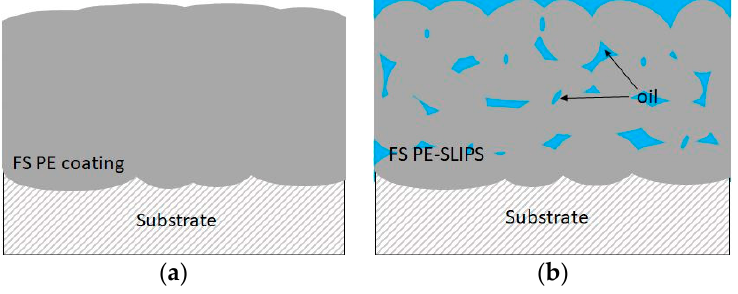
Figure 3. Schematic presentation of icephobic surfaces produced by using flame spraying ( a ) dense flame-sprayed (FS) polyethylene (PE) coating and ( b ) FS PE slippery liquid impregnated porous surfaces (SLIPS; porous structure with impregnated oil).